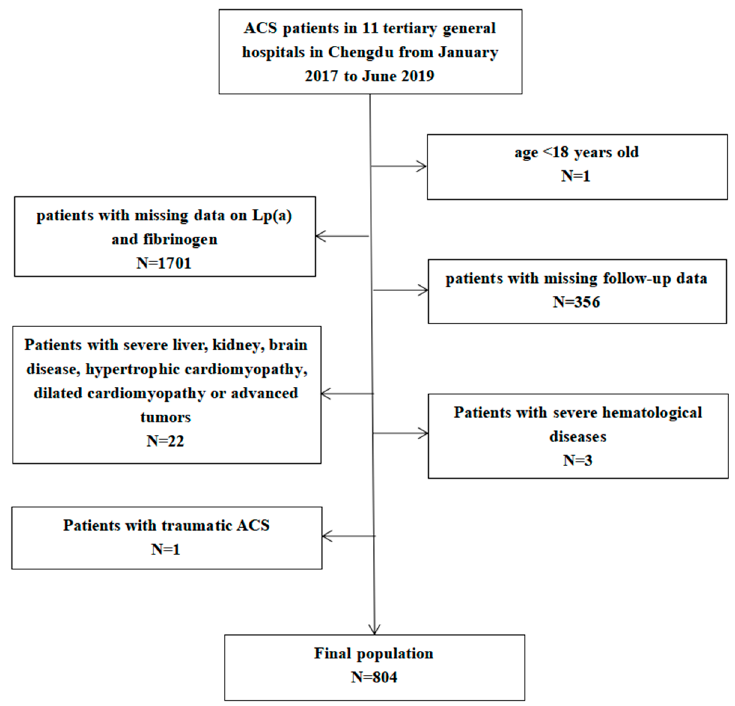
Figure 1. Screening process for patients. ACS: acute coronary syndrome.